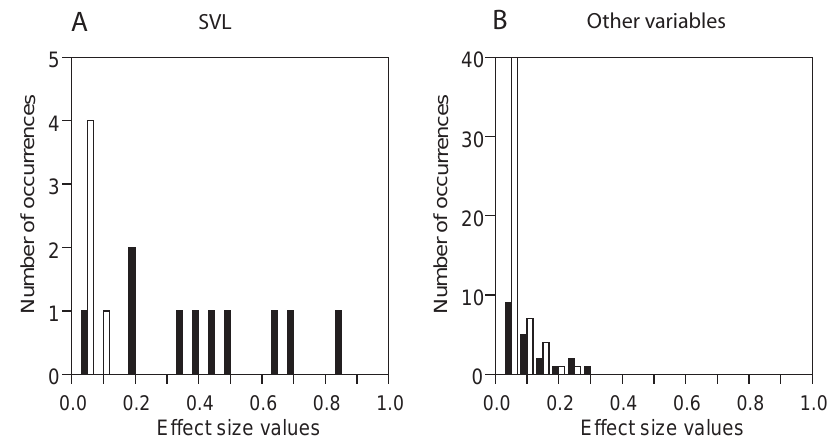
Fig. 6 – Distribution of effect size values for SVL (A) and other variables combined (head length, head width, etc.) (B). Solid bars are biologically significant values. Open bars are biologically insignificant values. Open bar on left of B has been truncated to 40 occurrences for purposes of display; the actual value is